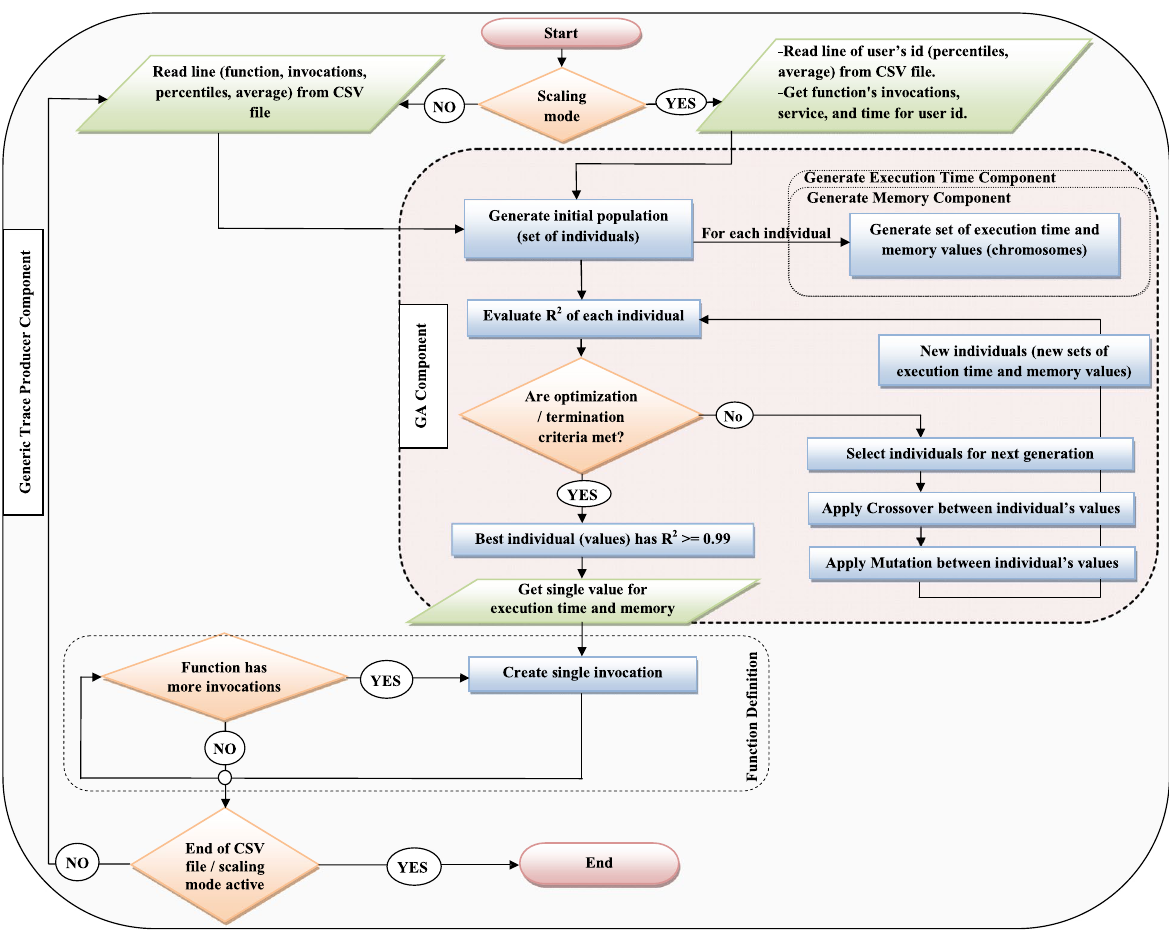
Fig. 2 Flowchart for process of generating